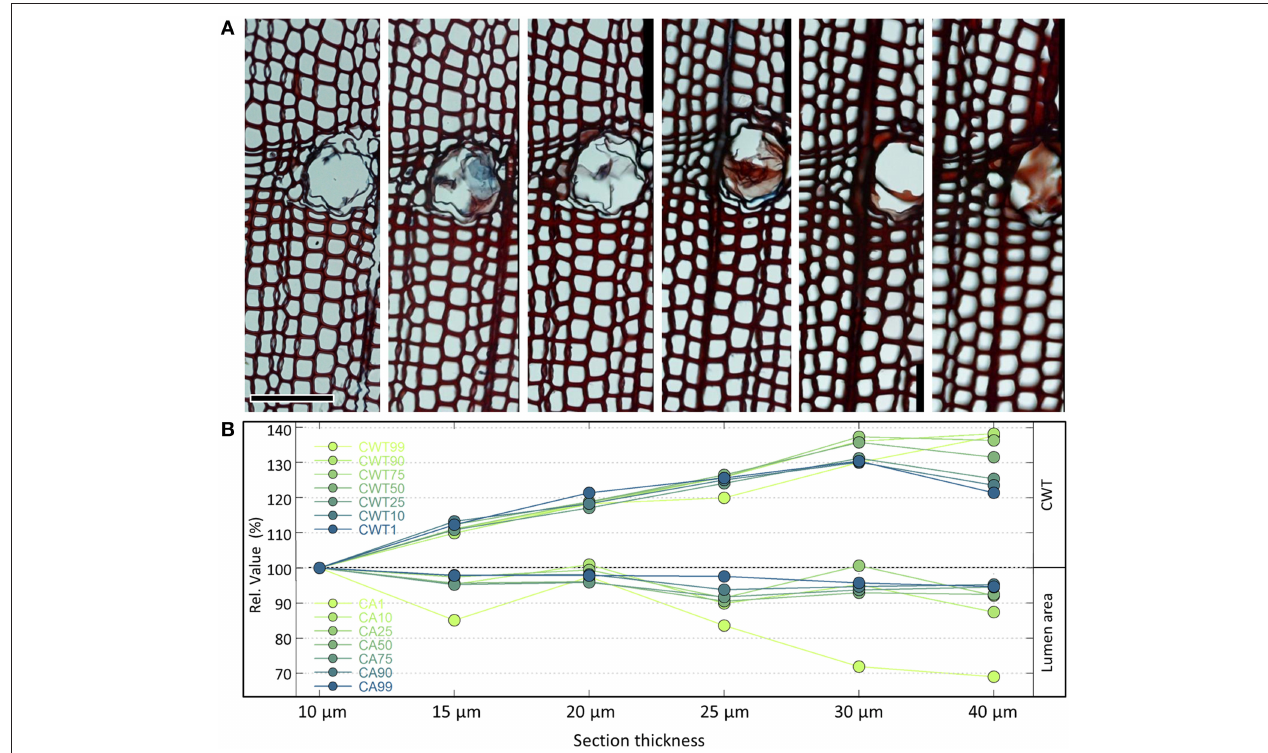
FIGURE 4 | (A) Series of cross-sections of the same Pinus heldreichii wood piece using different cutting thicknesses from 10 to 40 µ m (top row). The anatomical images are part of larger analyzed images containing each c. 4000 tracheids cells. The orientation of the samples is reasonably vertical, and images were produced keeping staining procedure and microscope settings standardized. Analyzing the images with the image-analysis tool ROXAS (cf. Table 1 ) using always the same settings reveals that the measured lumen area reduces markedly from the thinner to the thicker cross-sections (B) . This effect is stronger for smaller cells with a 31% reduction in the lowest percentile of the cell lumen population (CA1) than for the largest cells with only 4–6% reduction (CA90, CA99). In contrast, the mean tangential cell wall thickness appears also for the thinnest walls (CWT1, belonging to the largest cells) up to 30% larger in thicker compared to thinner cross-sections. For the thickest cell walls (CWT99, belonging to the smallest cells) the cutting-thickness error was up to 40%. Note that the quantification of the measurement errors is based on the shown example only. To a certain extent some of the cutting-thickness errors can be alleviated by adjusting the settings of the image analyses, particularly the segmentation threshold (see Section Image Segmentation and Figure 10 ). Scale bar = 100 µ